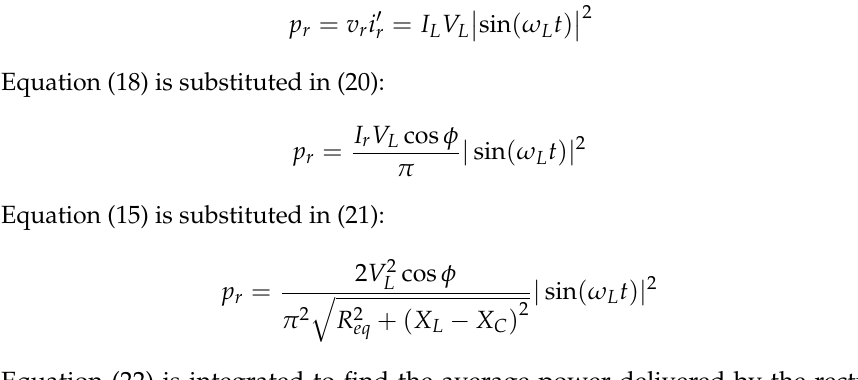
With Equations (19) and (9), it is possible to calculate the instantaneous power deliv-